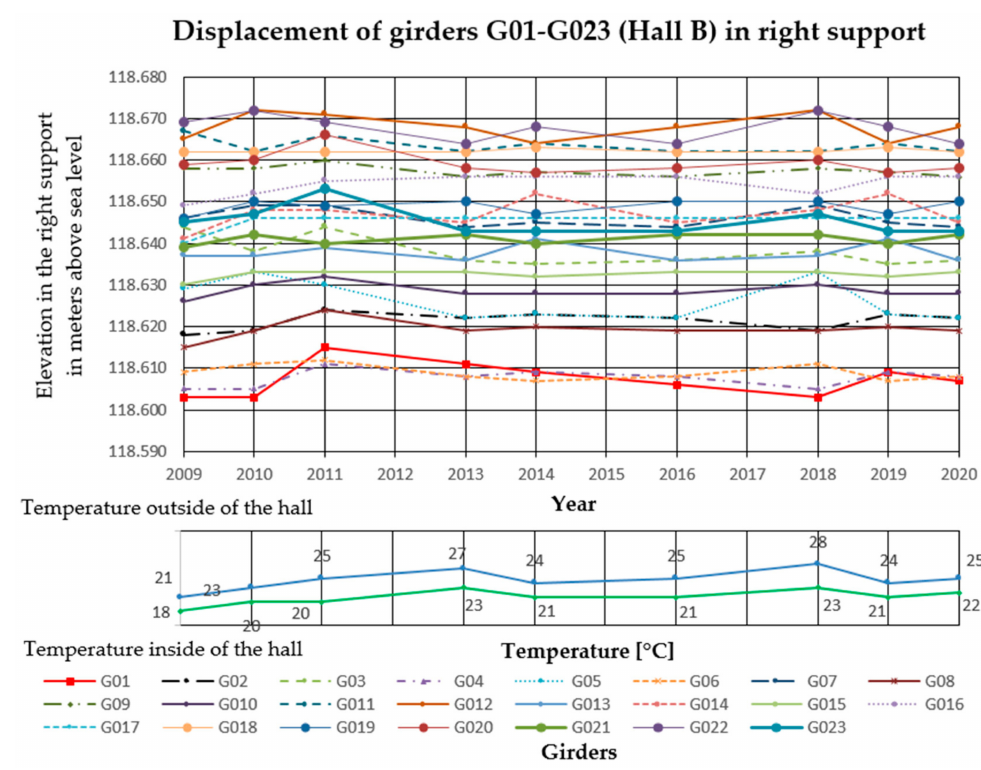
Figure 10. Displacement of the right side of the girders in Hall